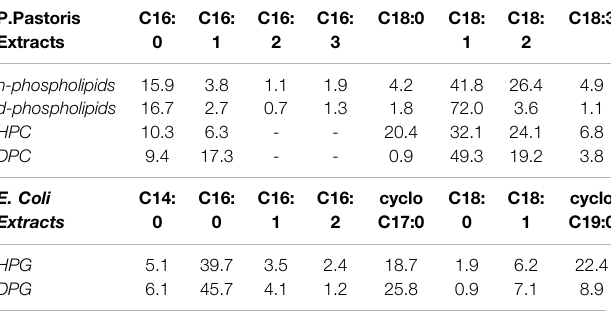
TABLE1| Compositionofdifferent P.pastoris lipidextractsexpressedas%molof thetotallipids. Theh-phospholipidandd-phospholipidextractscontainallthe phospholipids composing the total lipid extract. Their characterization and composition analysis was previously reported (Luchini et al., 2018). In the E . coli extracts, cyclo C17 and cyclo C19 acyl chains exhibit a cyclopropane ring in their chemical